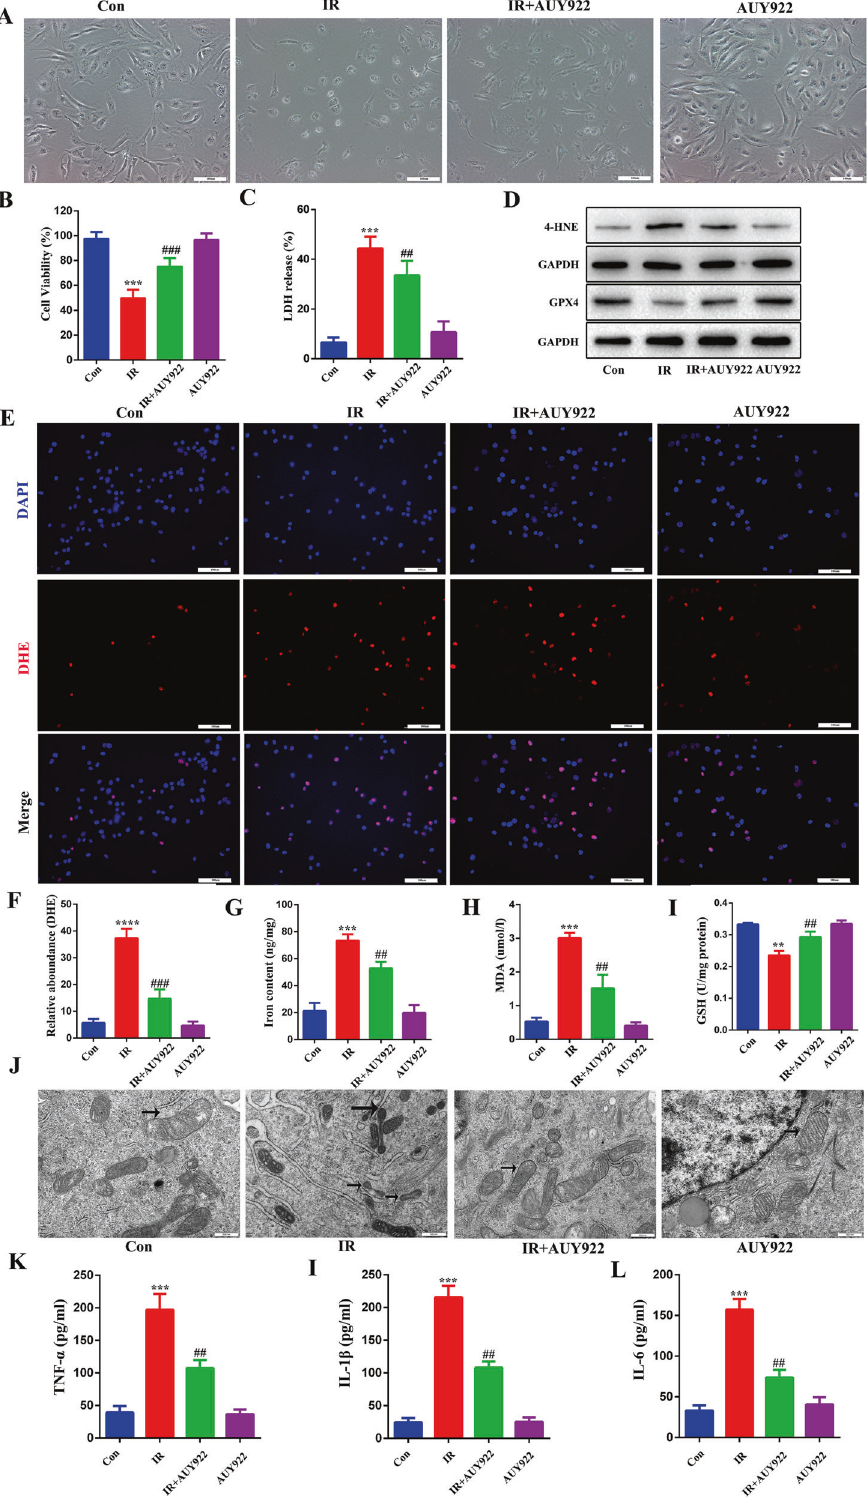
Fig. 4 NVP-AUY922 attenuates radiation-induced ferroptosis in BEAS-2B cells. A BEAS-2B cell morphology and death were observed. B , C CCK-8 assays and LDH release assays in BEAS-2B cell. D The levels of GPX4 and 4HNE in BEAS-2B cells. E , F Representative DHE fl uorescence images of BEAS-2B cells. G – I Activities of iron content, MDA, and GSH in cell culture supernatant. J Mitochondria with obvious characteristics of ferroptosis were detected by transmission electron microscopy. K – L Concentrations of TNF- α ( K ), IL-1 β ( I ), and IL-6 ( L ) in cell culture supernatant. #/ * P < 0.05, ##/ ** P < 0.01, ###/ *** P < 0.001, # vs. IR group; * vs. control group.